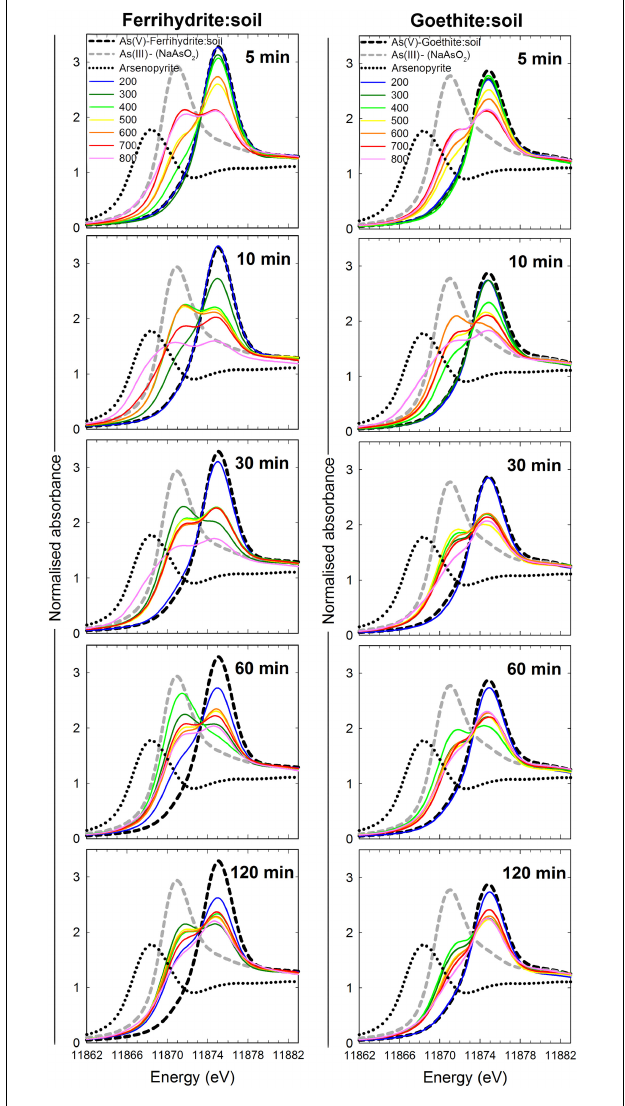
FIGURE 8 | As K-edge XANES spectra of ferrihydrite:soil and goethite:soil mixtures after heating at 200, 300, 400, 500, 600, 700, and 800 ◦ C for 5, 10, 30, 60, and 120 min. Dashed lines are reference spectra for As(V)-ferrihydrite:soil, As(V)-goethite:soil, As(III), and Arsenopyrite.